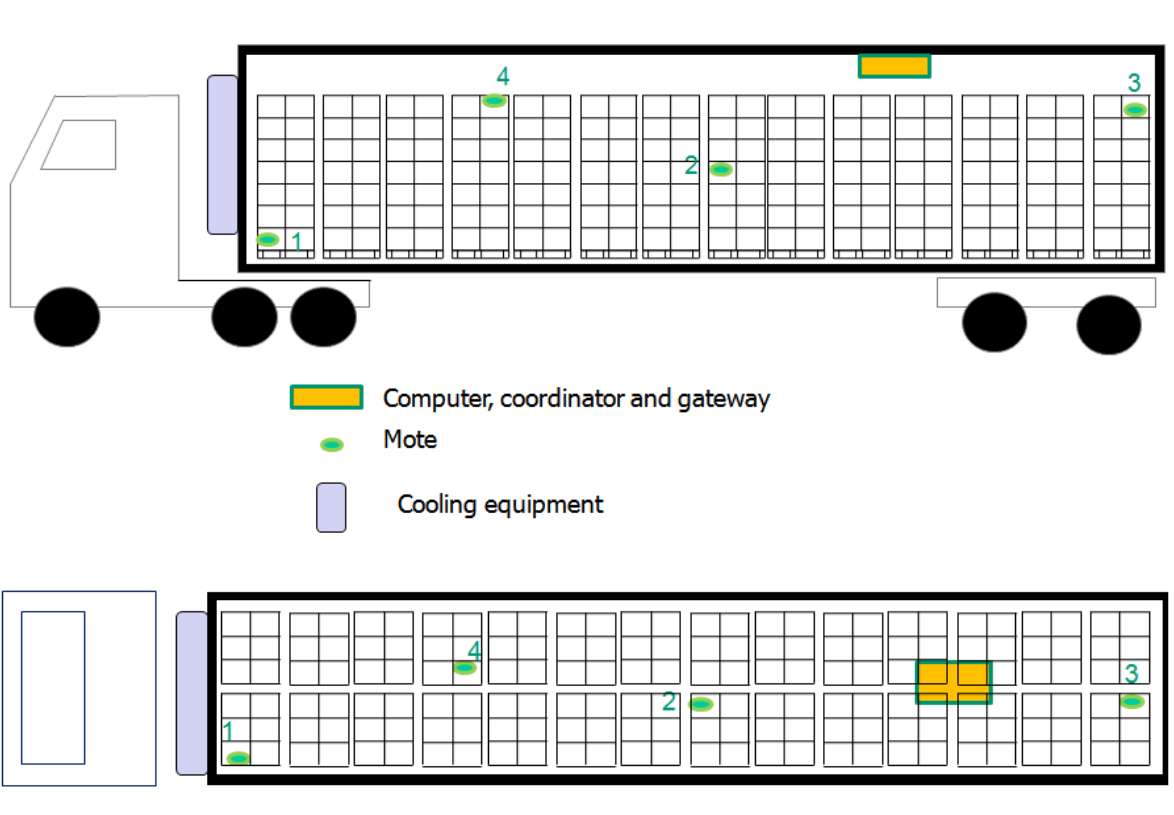
Figure 1. Experimental set-up. Side view and top